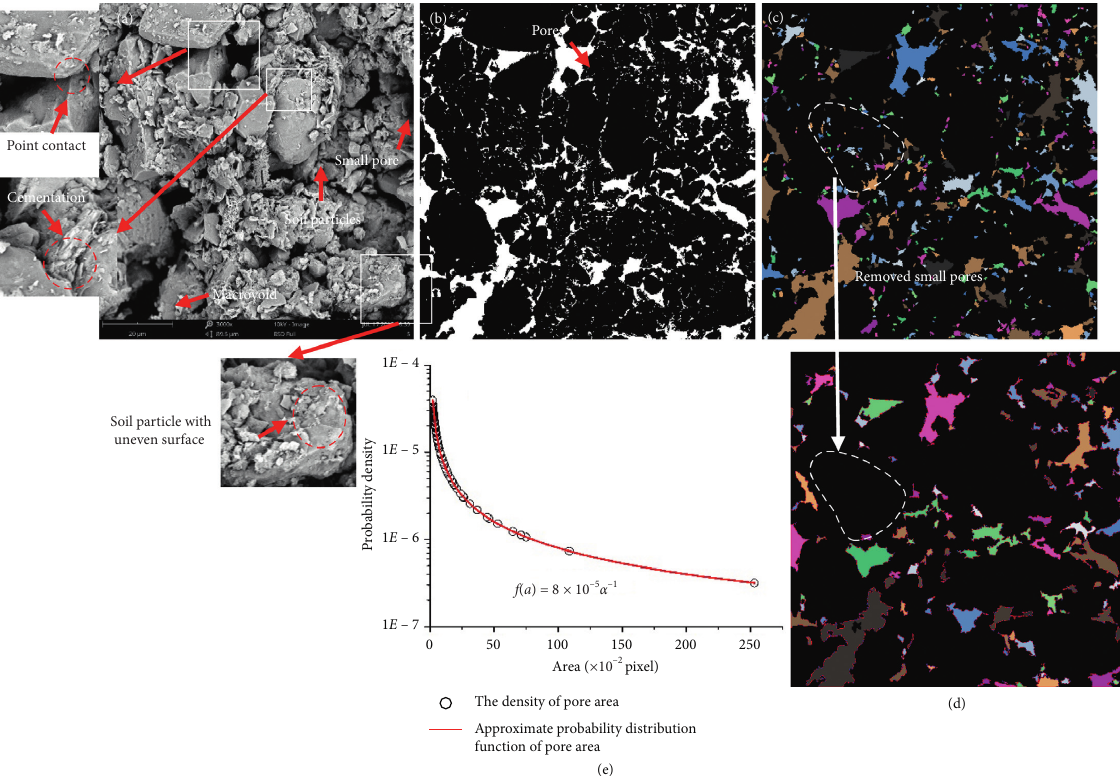
Figure 6: Original SEM image and PCAS proceeded images. (a) Original SEM image ( × 3000, 1024 × 1026 pixels, resolution 11.46 pixels/ μ m) of loess specimens. (b) Binary image (the threshold is 59). (c) Pore characterization with a minimum area of 20 pixels. (d) Pore char- acterization with a minimum area of 200 pixels (small pores are removed). (e) The probability density of pore area is approximated by a power